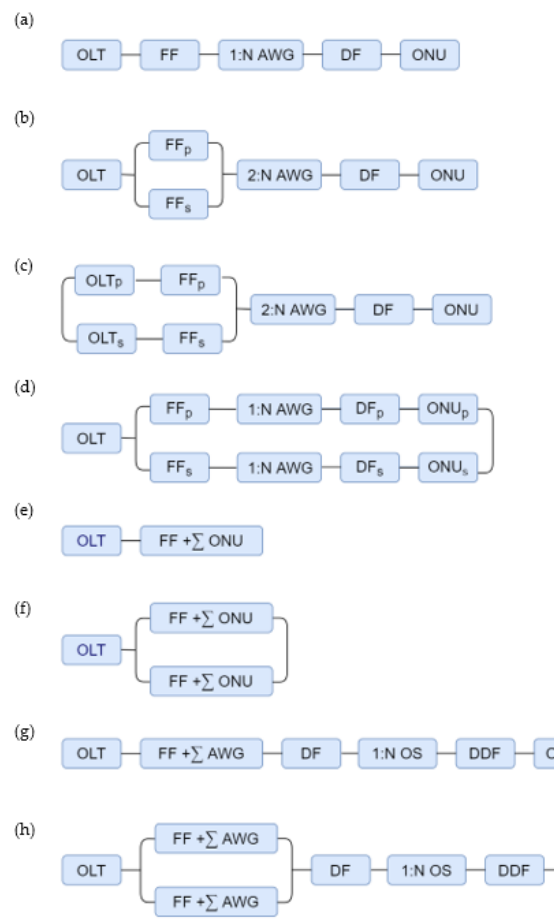
Figure 1. RBD diagrams for WDM-PON protection schemes ( a ) the unprotected P2MP network, ( b ) Type B protection, ( c ) Dual-parented Type B protection, ( d ) Type C protection, ( e ) the unprotected RING access network, ( f ) the protected RING access network, ( g ) the unprotected RING metro-access network, ( h ) the protected RING metro-access